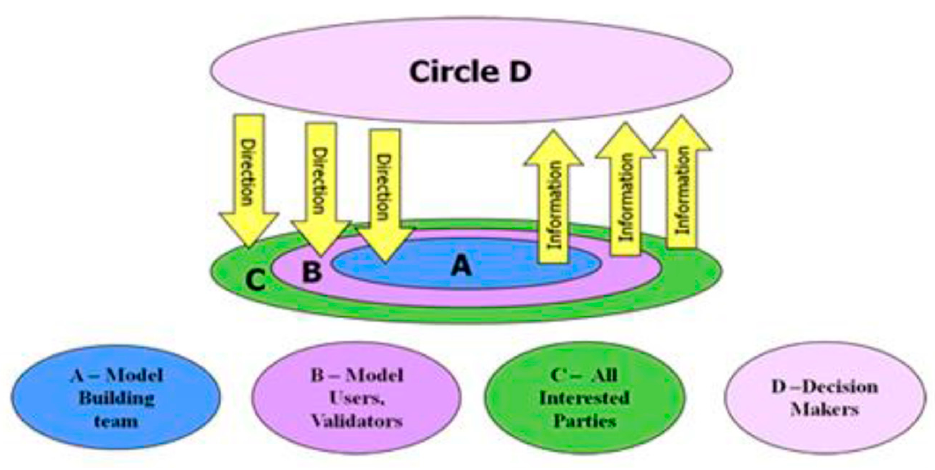
Figure 3. The “circles of influence” process framework [11].